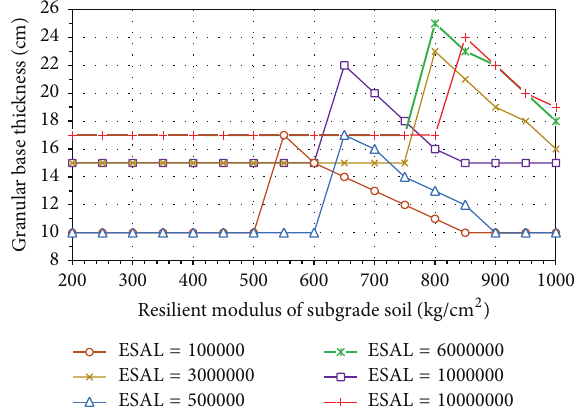
Figure9:Optimaldesignthicknessofgranularbaseforexpressways and freeways.